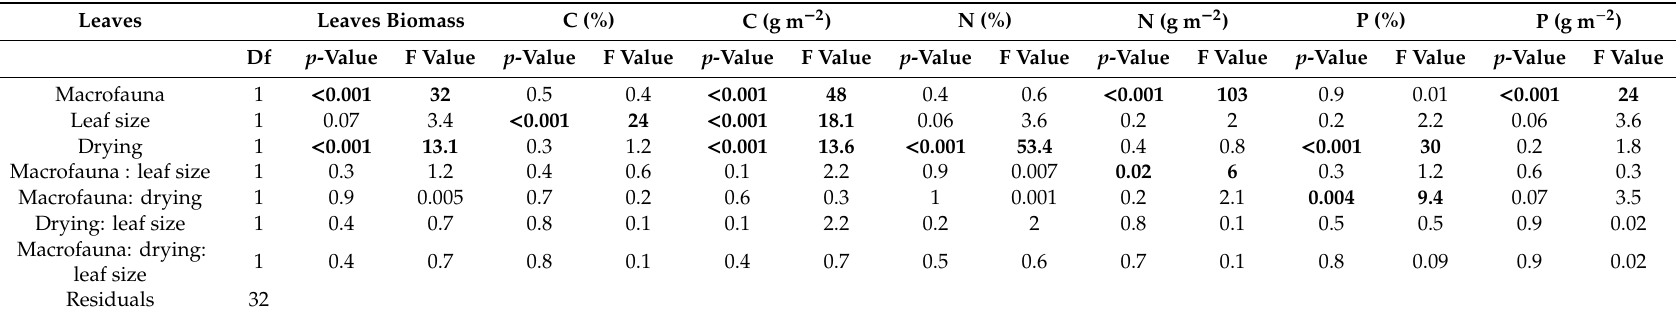
Table 3. Results of three-way ANOVA testing the e ff ects of the three factors macrofauna, leaf size and drying on residual leaf biomass and its C, N and P percentage and content at the end of the experimental period. Significant values are printed in